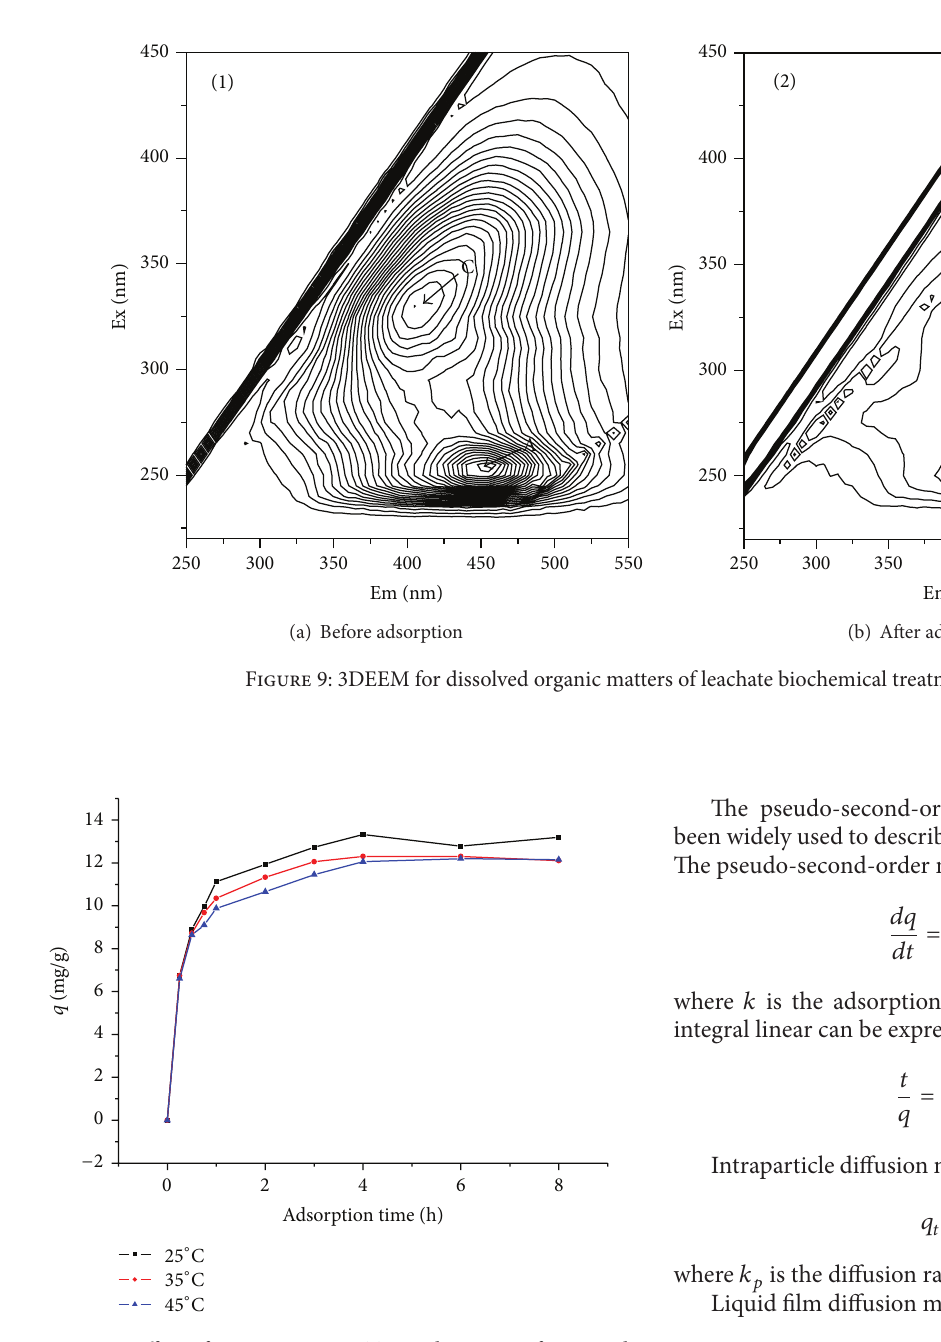
Figure 10: Effect of contact time on TOC adsorption of activated